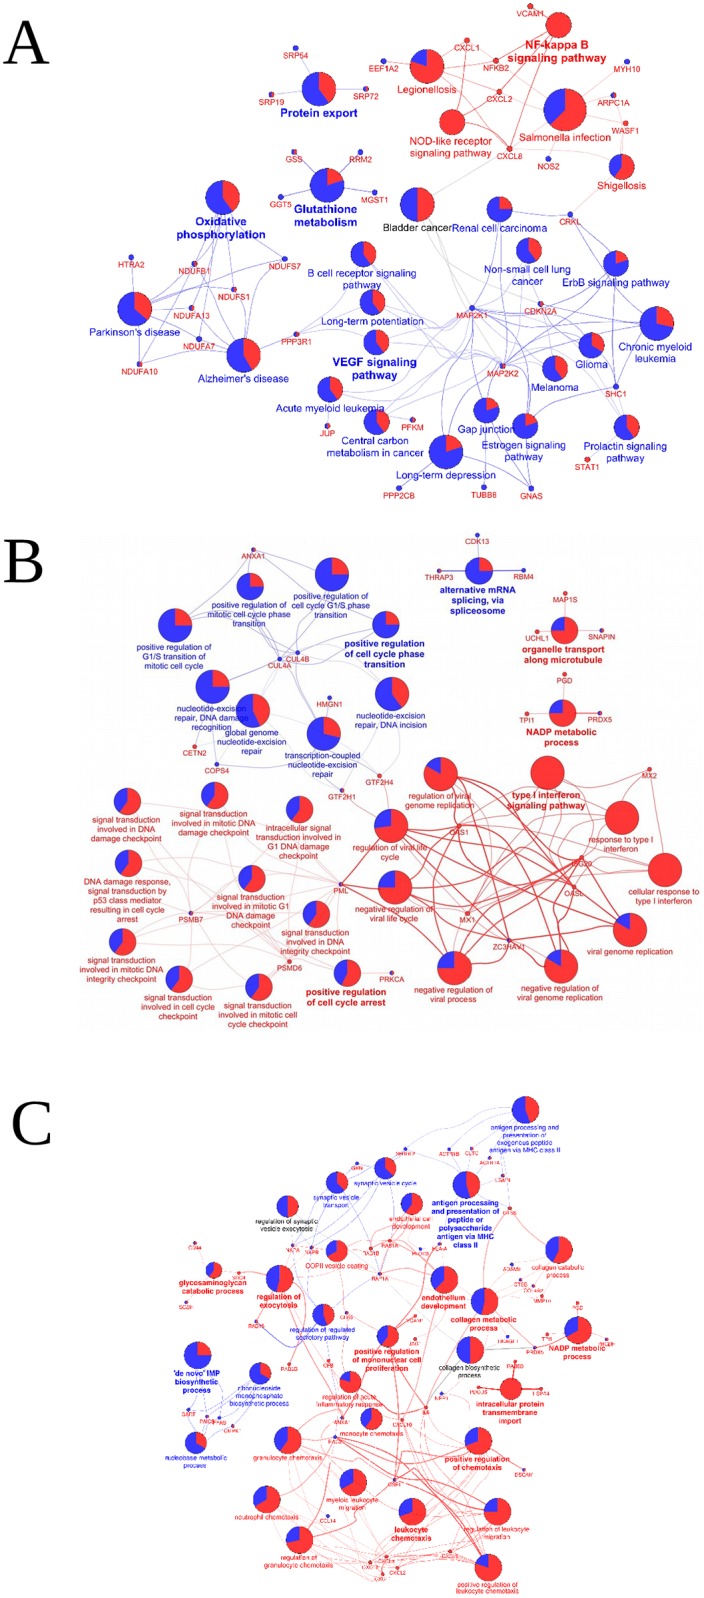
ClueGO analysis of the fractions of HUVEC treated with 10ng/mL IL-1β and HUVEC treated with 10ng/mL VEGF with untreated HUVEC as control.(A) cytoplasm fraction, (B) nucleic compartment, (C) extracellular fraction. Color depicts the fraction of induced proteins in IL-1β-treated HUVEC (red) and VEGF-treated HUVEC (blue). Node size depicts the p-value of the pathway. A summary of the analysis is provided in S2 Table.